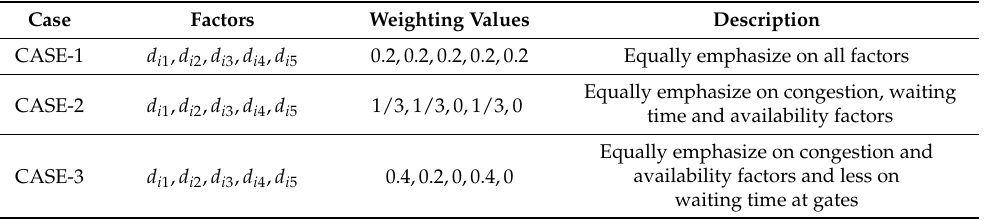
Table 3. Set of preferences and weights for the parking and routing